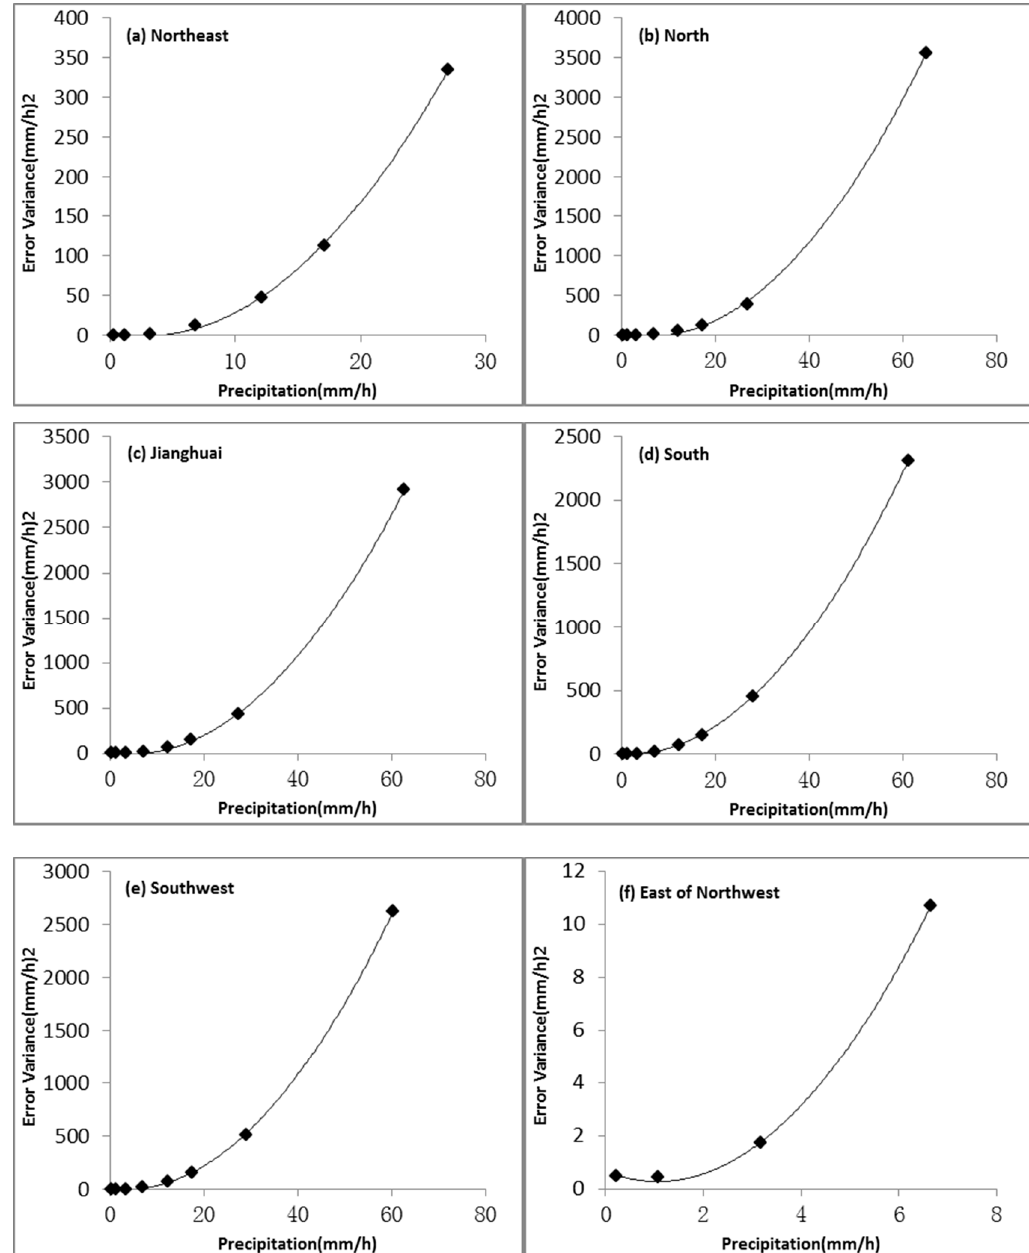
Figure 7. Error variance curves for the hourly radar QPE with precipitation at the 0.01° × 0.01° resolution in the six sub-regions in China. ( a ) Northeast (east of 110°E, north of 42.5°N), ( b ) north (east of 110°E, 35°N~42.5°N), ( c ) Jianghuai (east of 107.5°E, 27.5°N~35°N), ( d ) south (east of 107.5°E, south of 27.5°N), ( e ) southwest (97.5°E~107.5°E, south of 35°N) and ( f ) east of northwest (97.5°E~110°E, north of 35°N) (Shi and Xu, 2006).